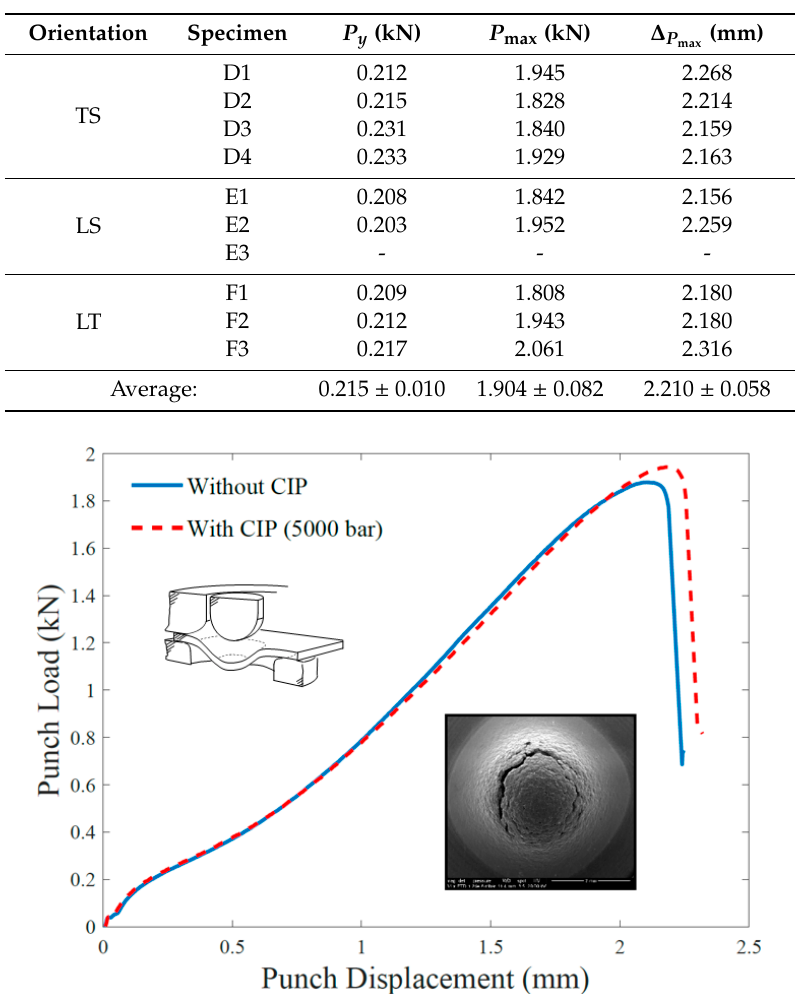
Figure 5. SPT load–displacement curves (TS orientation) for the AISI 316L with and without CIP.